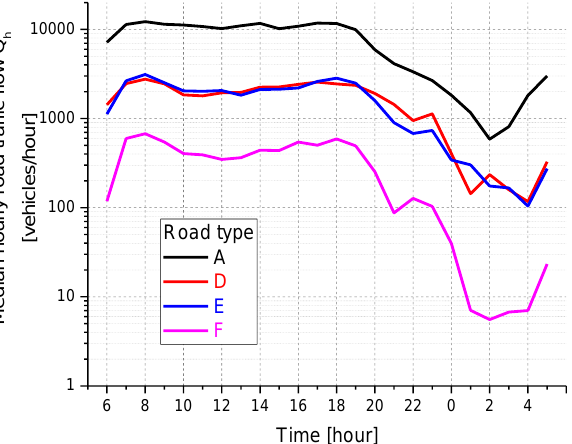
Figure 6. Median hourly road traffic flow Q h computed for the examined dataset and the four road